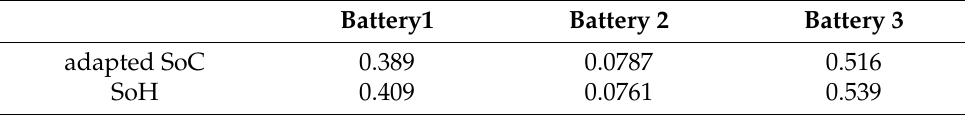
Table 21. Capacity fade of the control strategies for Case 3.